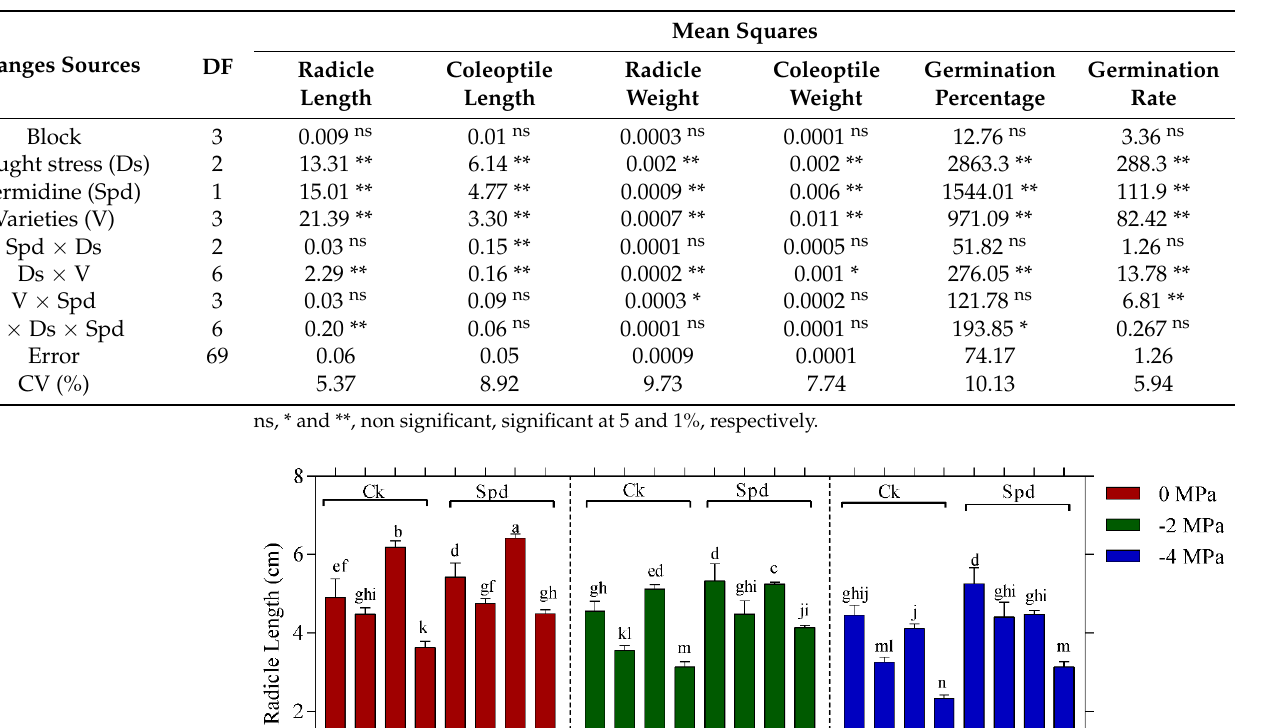
Table 1. Results of variance analysis of the effect of Spd and three levels of PEG 6000 osmotic potential ( − 2, − 4 Mpa and 0 using distilled water as control) on some morphological characteristics of wheat varieties.